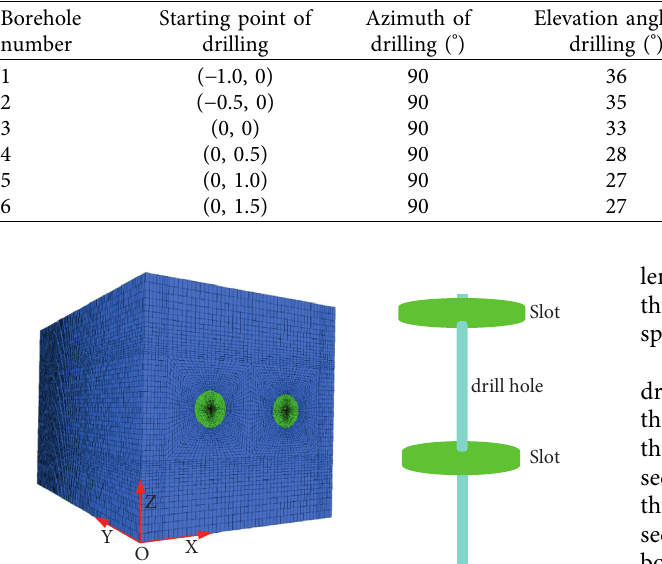
Figure 13: Double-drilling hole and double-slot